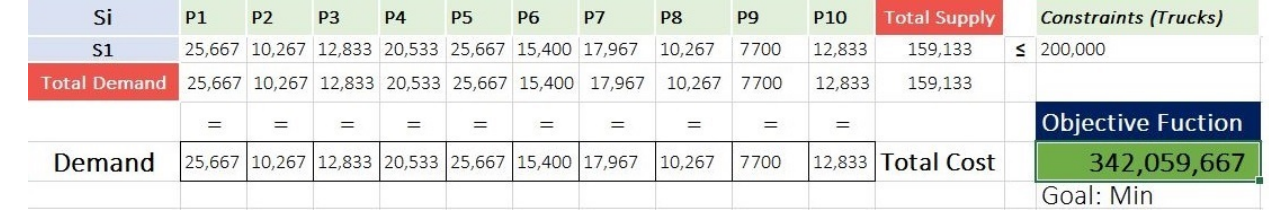
Figure 8. Scenario1 for SPL S 1 .